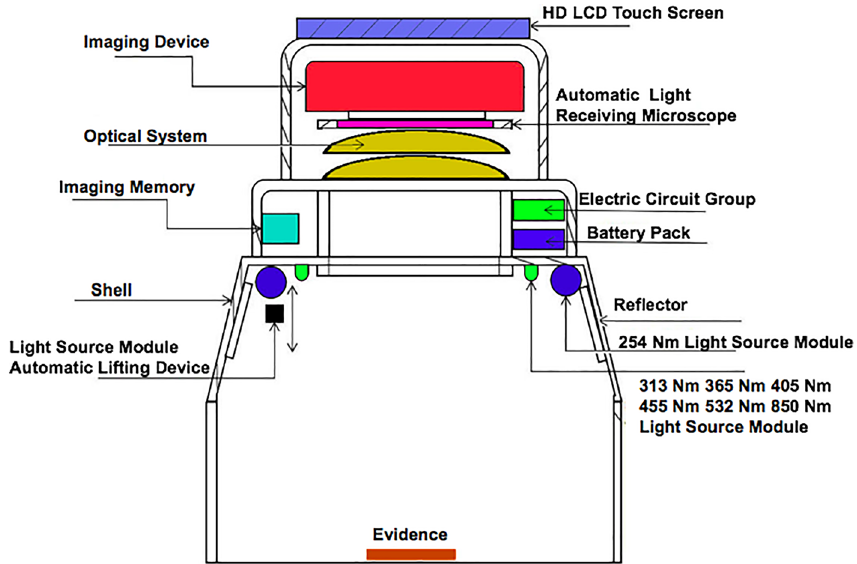
Figure 5. The overall design of the equipment.